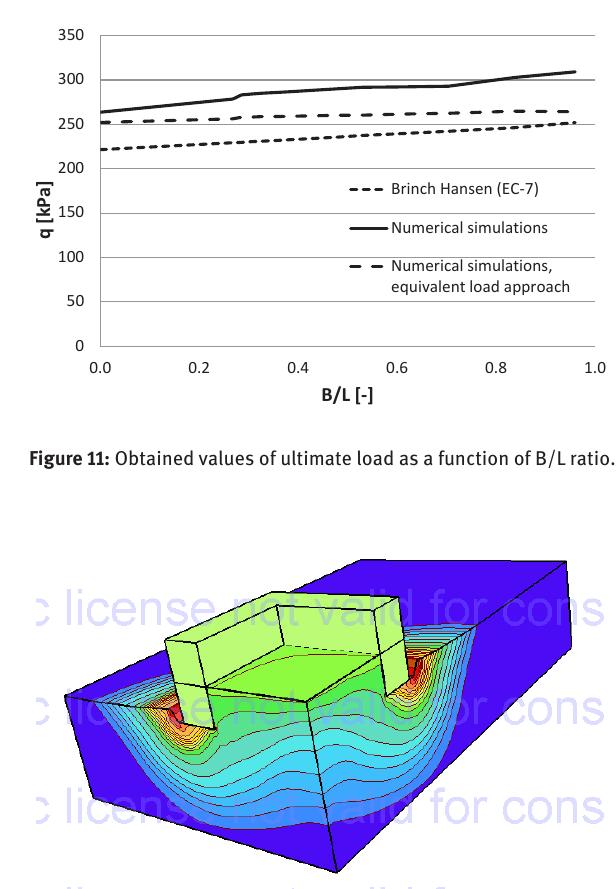
Figure 10: 3D numerical model of the bench and slab, equivalent load approach.